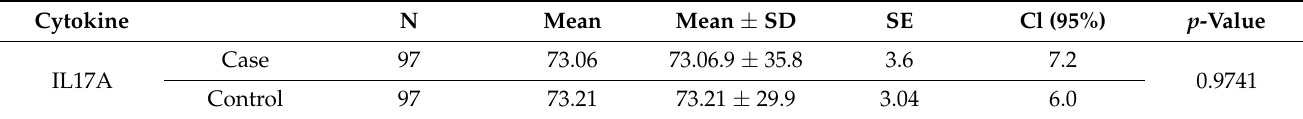
Table 2. IL17A serum concentration (case vs. control).